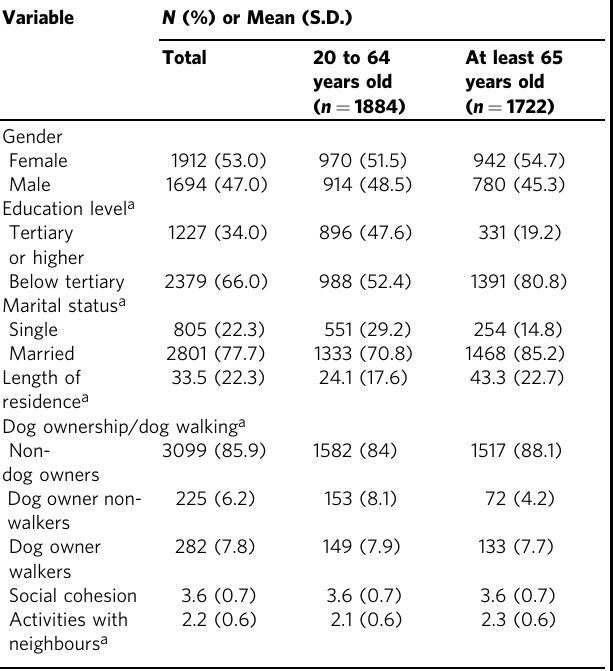
Table 1 Characteristics of the study participants ( N = 3606). Table 2 Social capital scores among the non-dog owners, dog owner non-walkers, and dog owner walkers